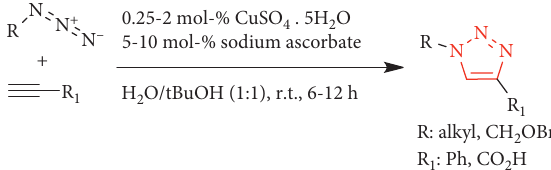
Scheme 5: Copper-catalyzed azide-alkyne